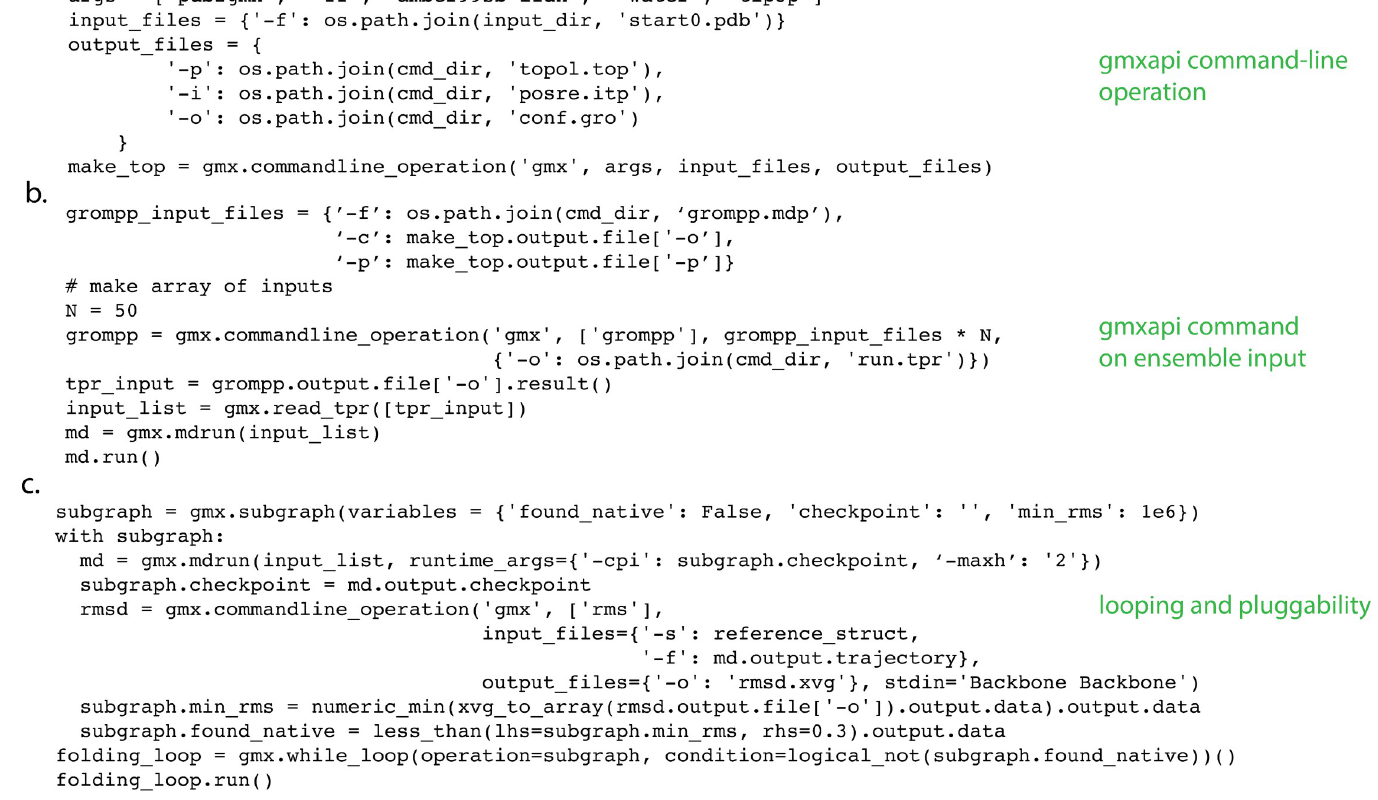
Fig 1. gmxapi usage examples. Panel (A) shows an example of the commandline_operation function by which gmxapi can reproduce any GROMACS functionality. Panel (B) shows gmxapi molecular dynamics calls operating on ensemble input, providing straightforward high-level parallelism in addition to parallelization within each command. Panel (C) demonstrates both a while loop and pluggability of gmxapi components. Together, the examples will execute an ensemble of small protein folding simulations until at least one ensemble member samples the native state.